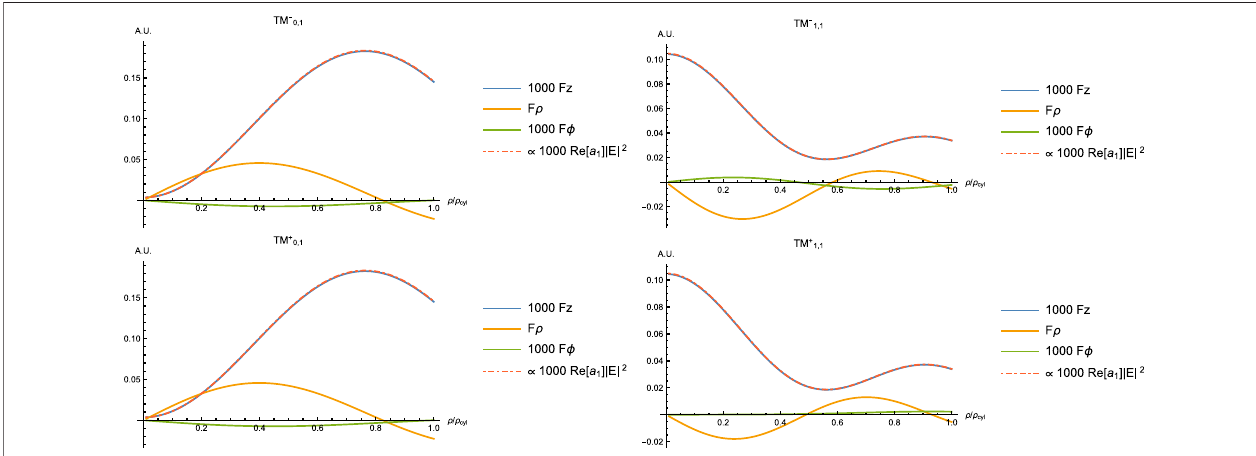
FIGURE5| First TMmodes: optical forces seenaspro fi le fromthecentertothewalls ofthewaveguide. Aswehave the (cid:6) ρ pointing outwards thewaveguidepro fi le, the F ρ < 0actsascontrarytothisdirection,bringingtheparticletothecenterofthewaveguide.Calculationswereperformedusingthefullexpressionson Eqs23 and 24 , assuming a waveguide radius of 5 µm, and a size parameter x (cid:1) 0.1.